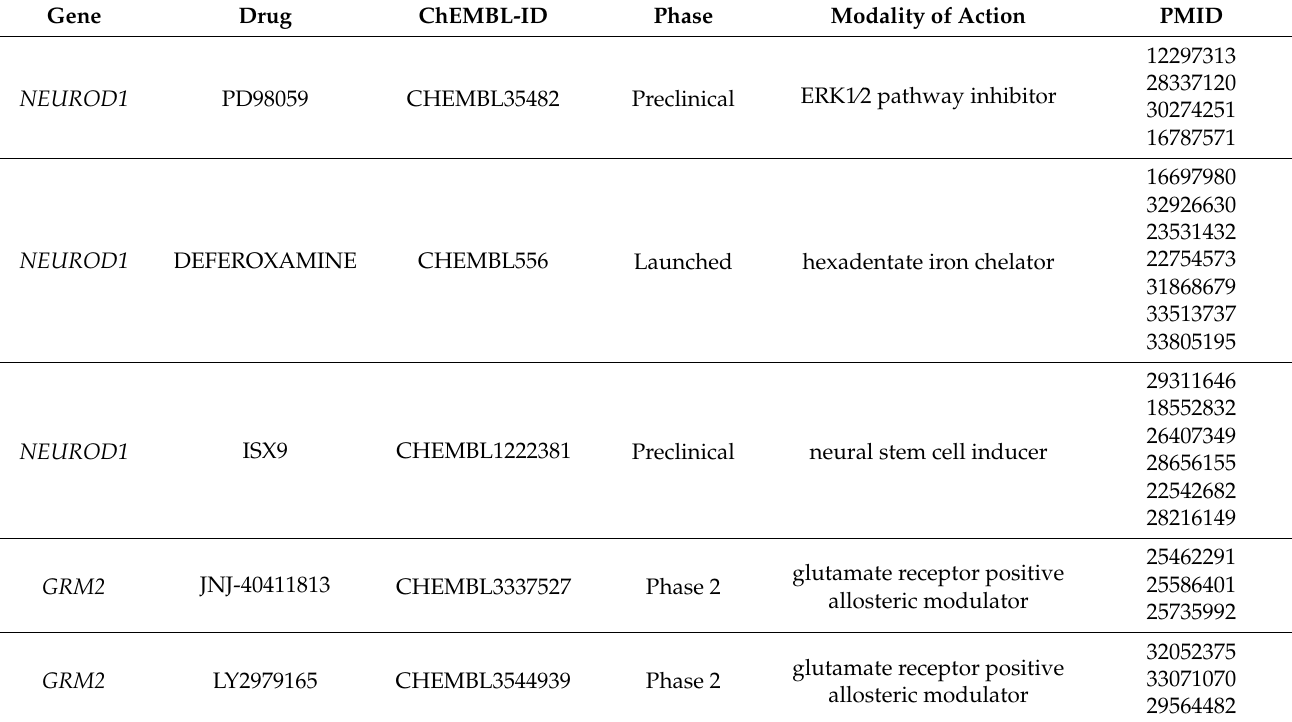
Table 1. Compounds and drugs obtained from the drug repurposing pipeline. The modality of action of each compound was identified on DGIdb and validated through extensive literature assessment; PMIDs are reported in the